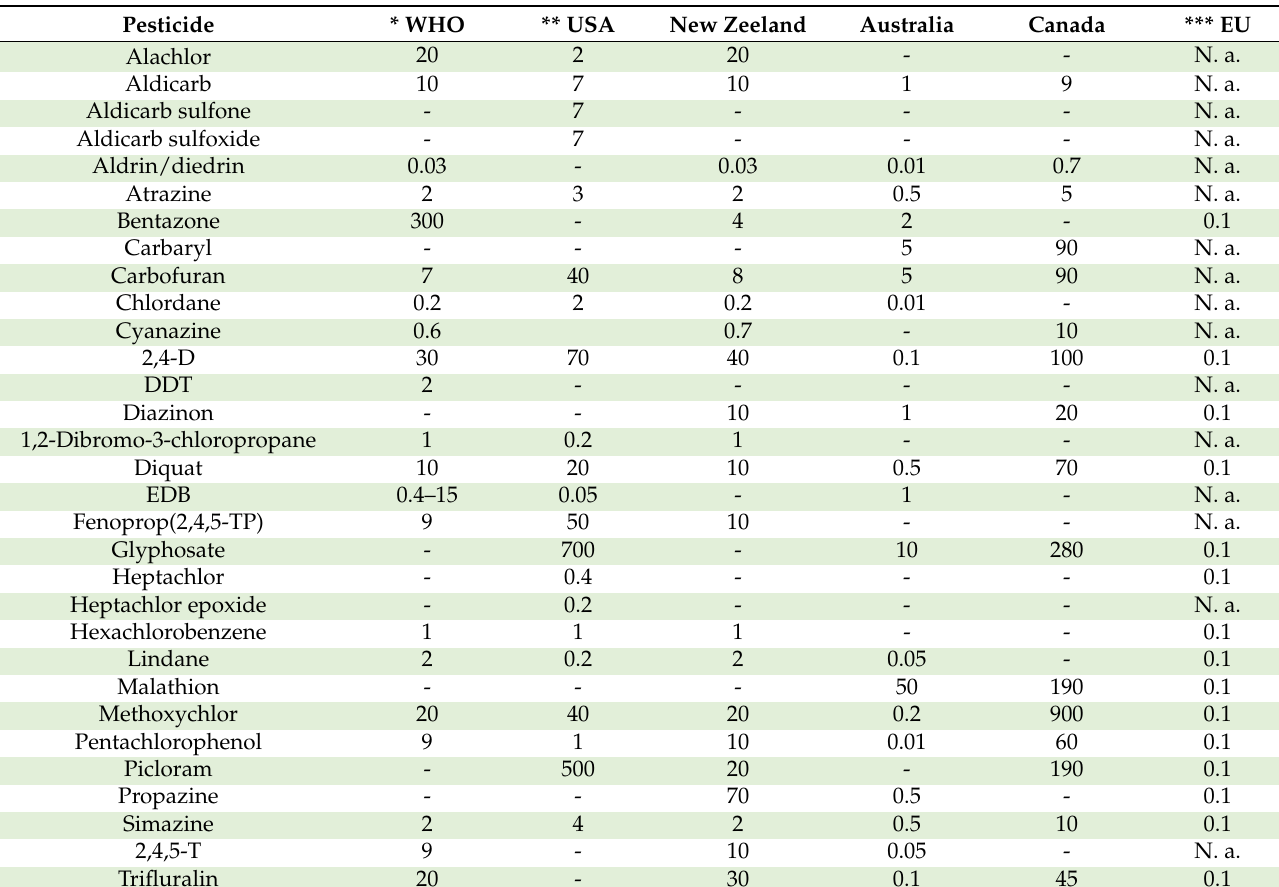
Table 1. Comparison between different guideline values for pesticides in drinking water [39]. For EU the Drinking Water Directive (DWD) sets a concentration limit of 0.1 µ g/L for individual pesticides and of 0.5 µ g/L for the total sum of pesticides [40]. Values are expressed in µ g/L, N. a. = not approved.